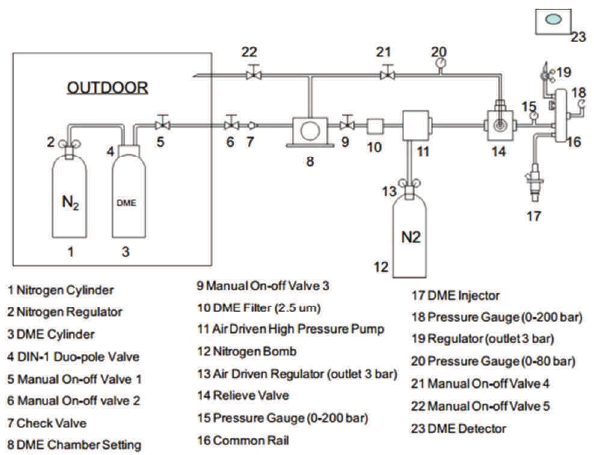
Fig. 2. Experimental test stand for DME direct injection [1]